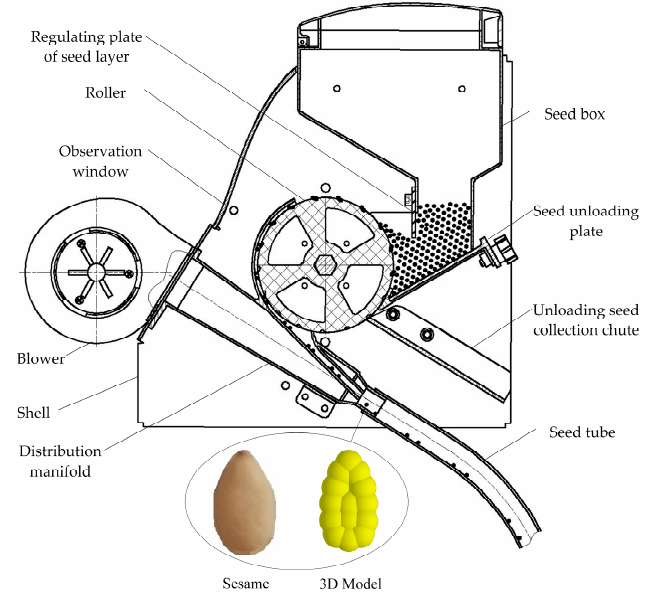
Figure 3. Functional diagram of seeding system.